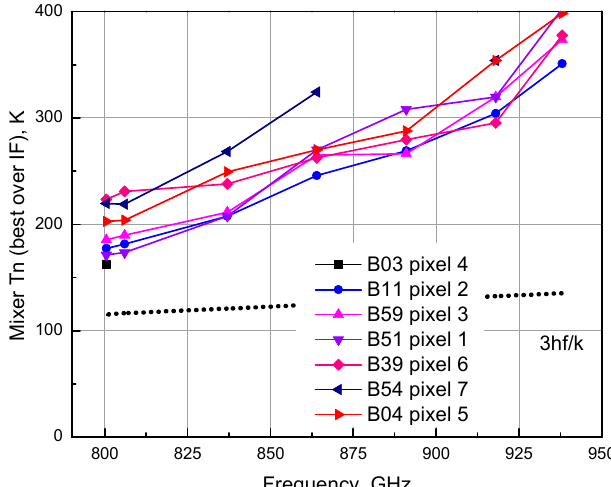
Figure 14. The best noise temperature over the IF band as a function of LO frequency. The data are corrected for the beam splitter the same as in Figure 13.